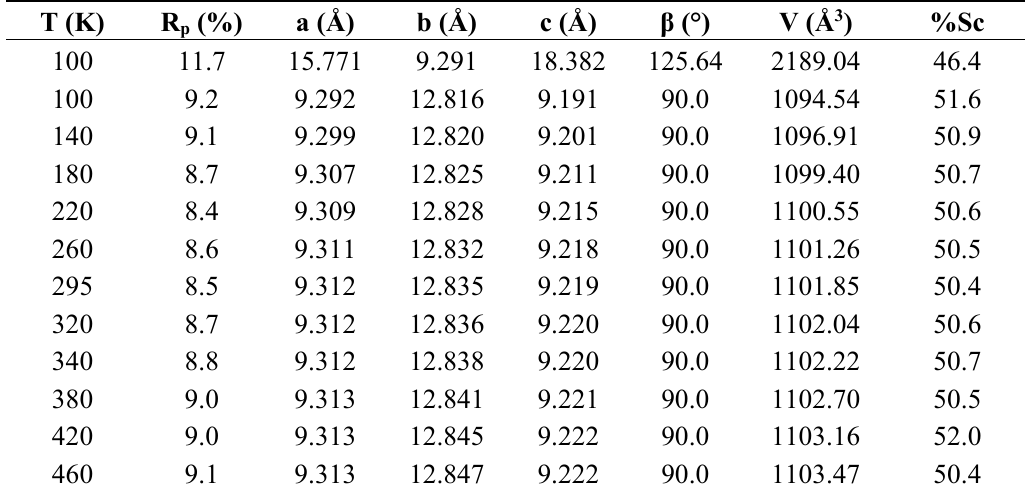
Table 2. Rietveld refinement results of variable temperature diffraction data of AlScMo 3 O 12